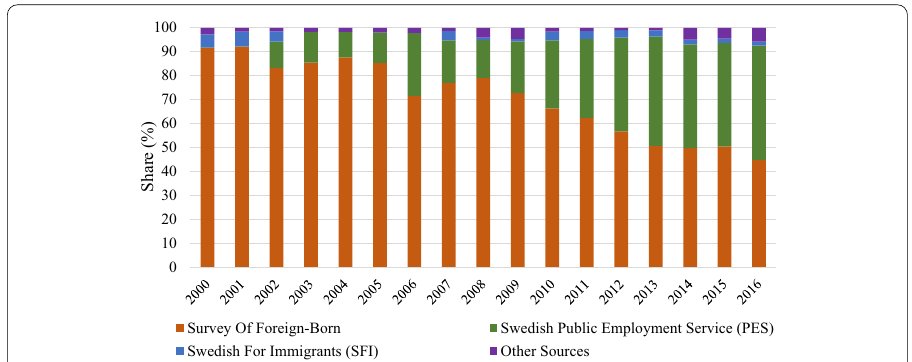
Fig. 2 Sources of information on educational attainment for immigrants arrived in the period 2000–2016. Immigrants with missing values are not included. Variables measured on December 31 in year of